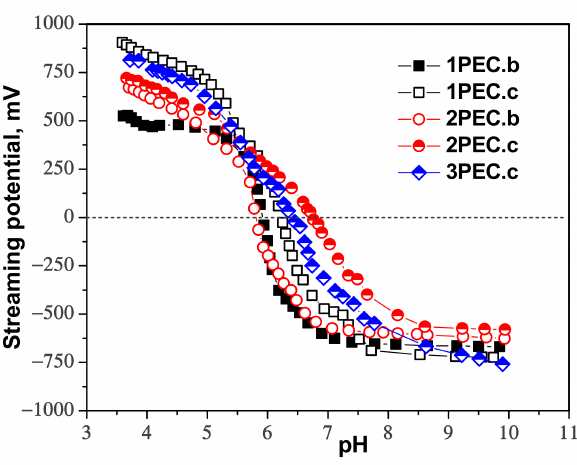
Figure 5. Streaming potential measurements of the PEC cryogels as a function of